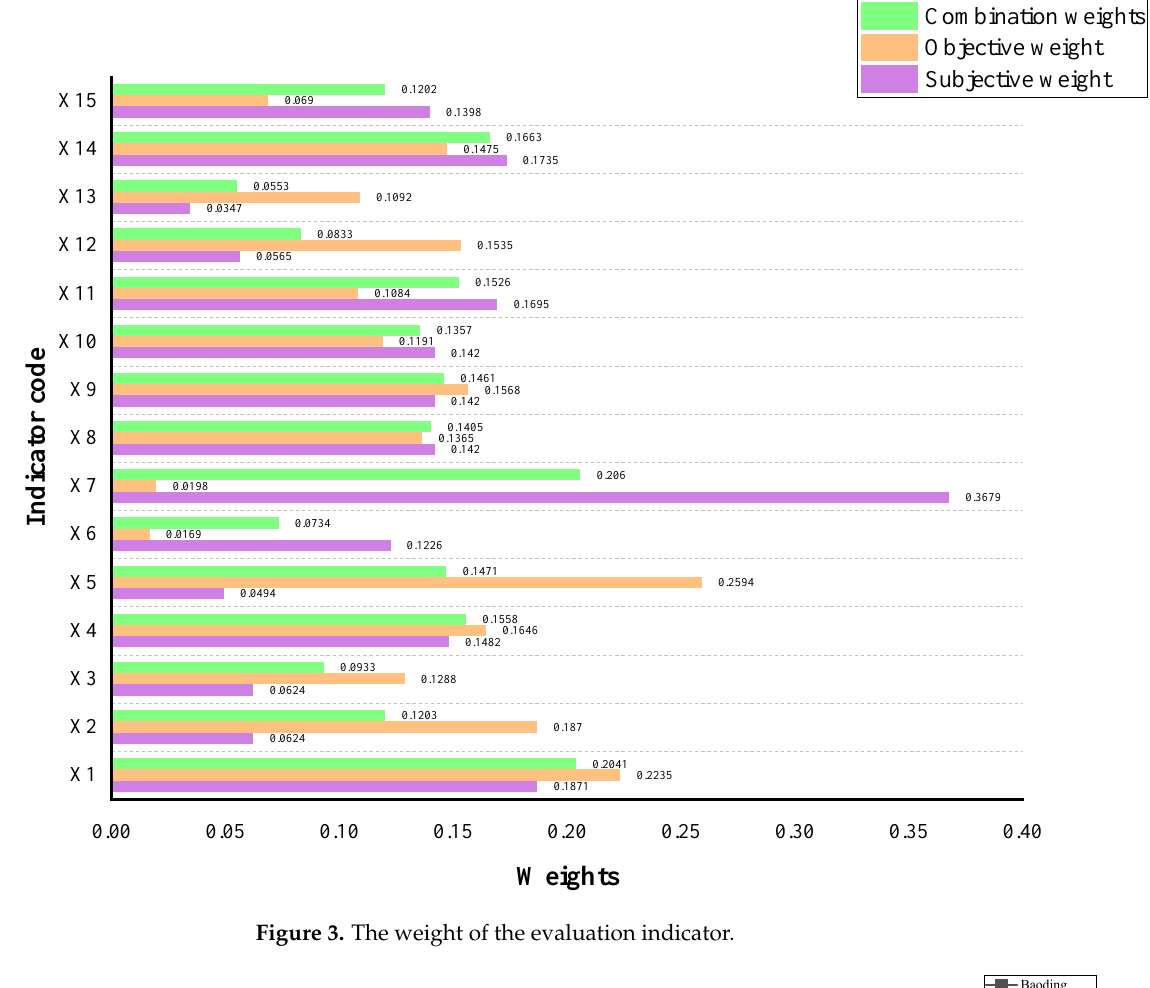
Figure 5. Comprehensive score for industrial ecosystem development.